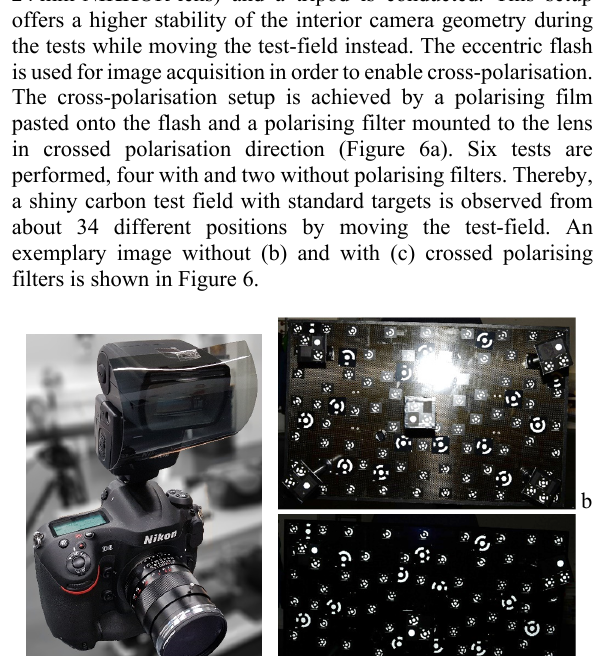
to radial-symmetric lens distortion as well as decentring distortion, affinity and shear is very low but present.